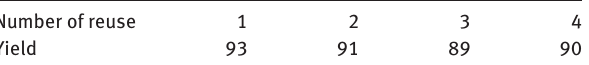
Figure 3: Effect of temperature on yield of 11,15-dimethyl-hex- adeca-8,10,14-trien-7-one. (2-Octanone/citral molar ratio of 10, catalyst amount of 5%, 3.5 h).